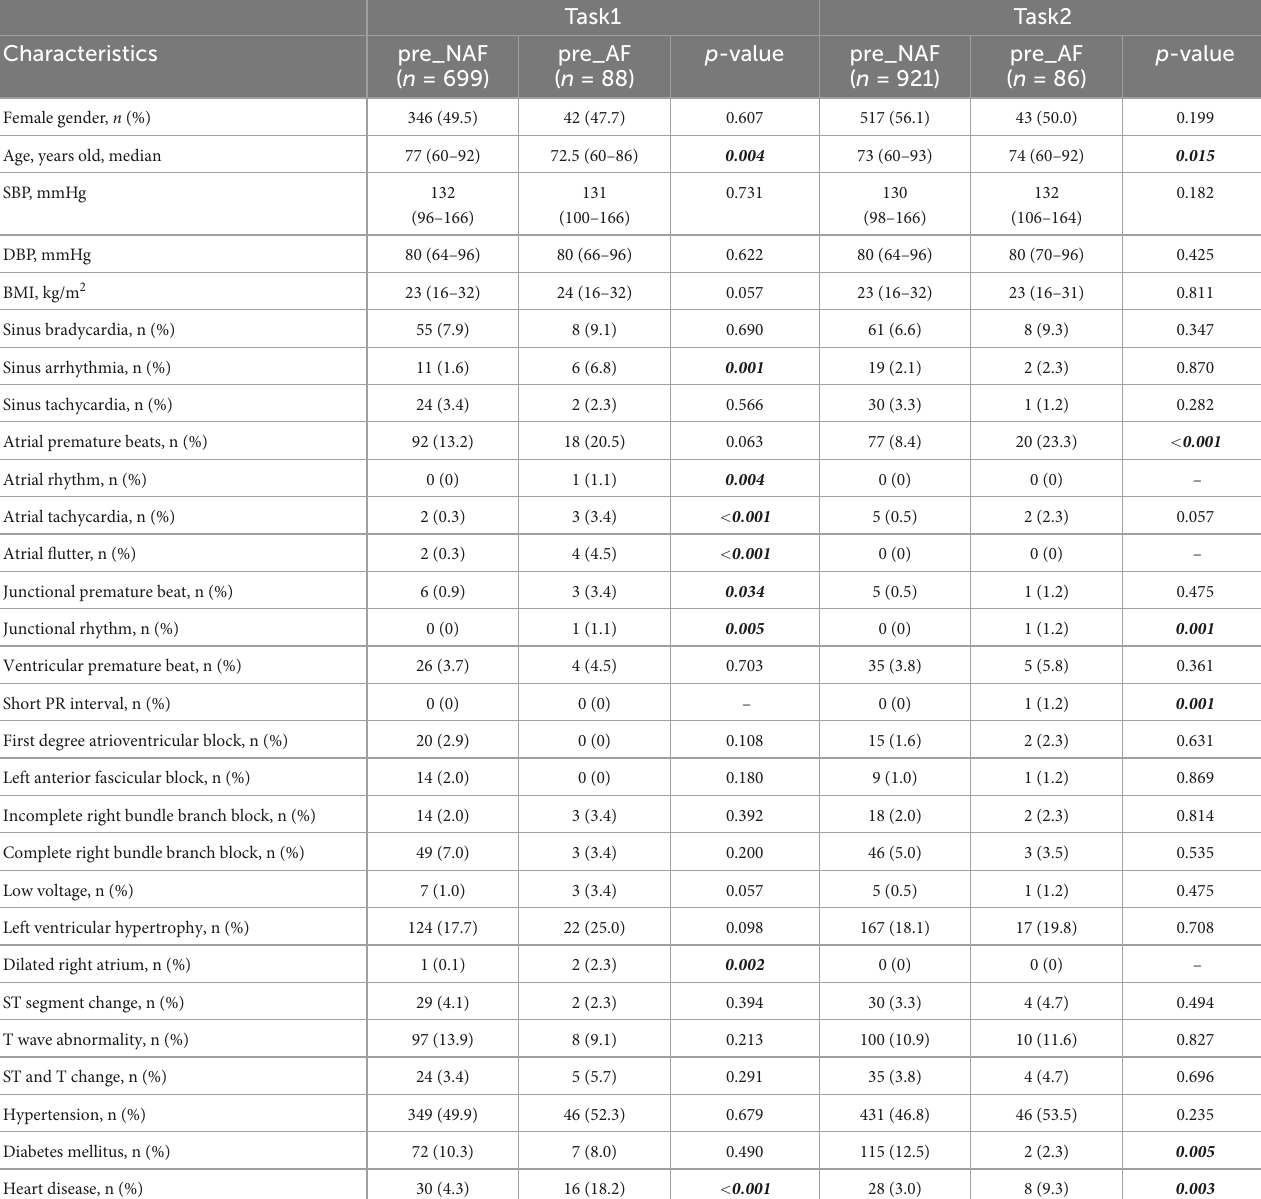
TABLE 3 Subjects’ characteristics at baseline in tasks 1 and 2.